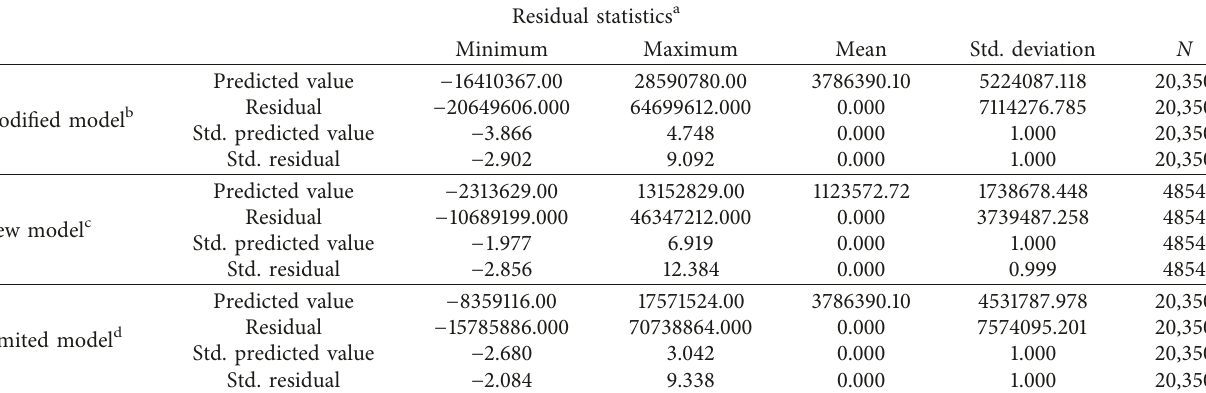
Table 8: Residual statistics for a DOE small office building depending on different